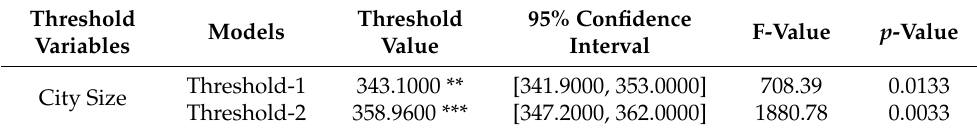
Table 6. Results of the self-sampling test for the threshold